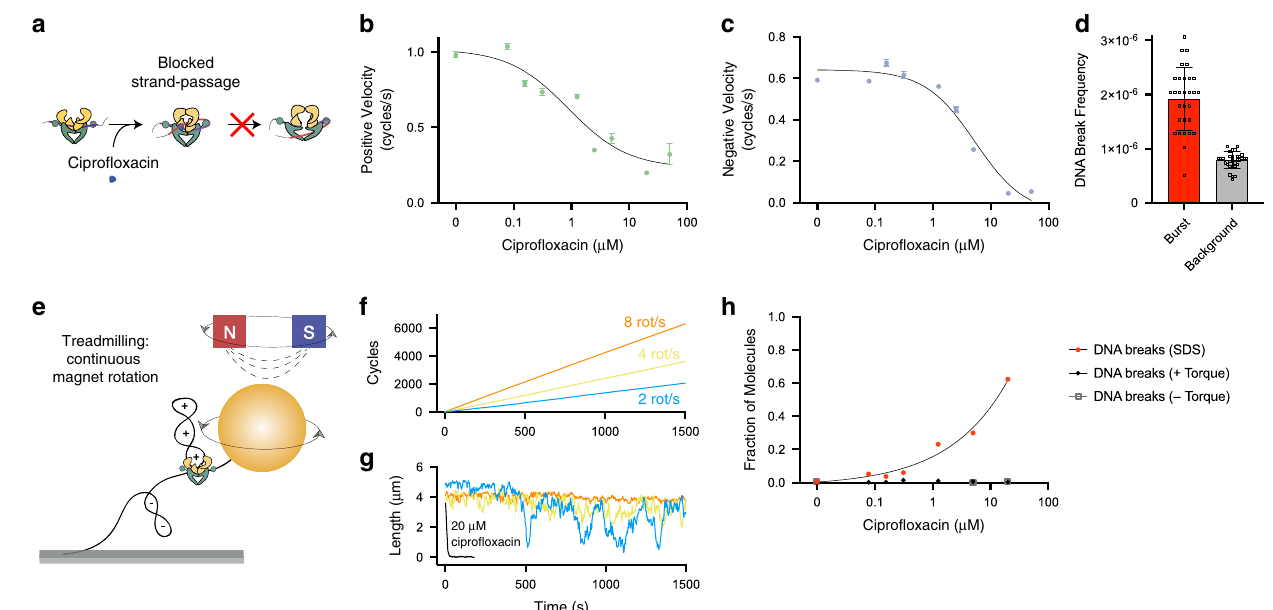
Fig. 5 Gyrase inhibition and DNA break formation due to cipro fl oxacin. a Enzymatic cycle of gyrase. Gyrase binds a gate segment, makes a transient DNA break, and passes a transfer segment through. Cipro fl oxacin prevents resealing of the break. b The velocity of positive supercoil relaxation as a function of cipro fl oxacin concentration. The IC50 from the inhibitor versus response equation (Y = Bottom + (Top-Bottom)/(1 + (X/IC50))) was 0.94 µ M (0.2 – 4.1; 95% CI). c The velocity of negative supercoil relaxation as a function of cipro fl oxacin concentration. The IC50 from the inhibitor versus response equation (Y = Bottom + (Top-Bottom)/(1 + (X/IC50))) was 5.3 µ M (2.6 – 12.1; 95% CI). Error bars represent the s.e. median. The total burst counts for individual experiments are provided in the “ Statistics and reproducibility ” section. d Frequency of DNA breaks that occur during bursts of gyrase activity (red) compared to background (gray) normalized by the mean burst length ( n = 26,063 molecules from ten independent experiments). In total 26 breaks were observed with eight occurring during bursts (Supplementary Fig. 5). Error bars represent s.d. determined by 30 cycles of bootstrapping. e Treadmilling assay developed to observe continuous gyrase activity for long periods. The magnet is continuously rotated to introduce positive supercoils. Gyrase continuously resolves the positive supercoils as they form (Supplementary Fig. 6). f Number of gyrase reaction cycles performed as a function of time from a single molecule for different rotation speeds. g DNA length changes during the treadmilling assay. Loss of activity and rapid compaction in the presence of cipro fl oxacin is shown in black for eight rotations per second. h Fraction of molecules with DNA breaks as a function of cipro fl oxacin concentration, positive and negative torque, and SDS